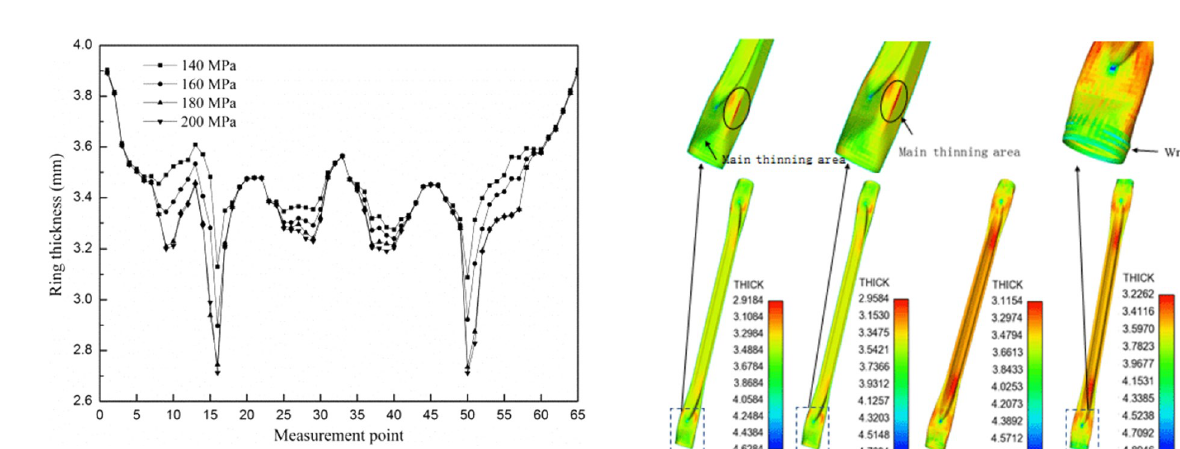
Figure 39 Wall thickness distribution of the F–F cross section